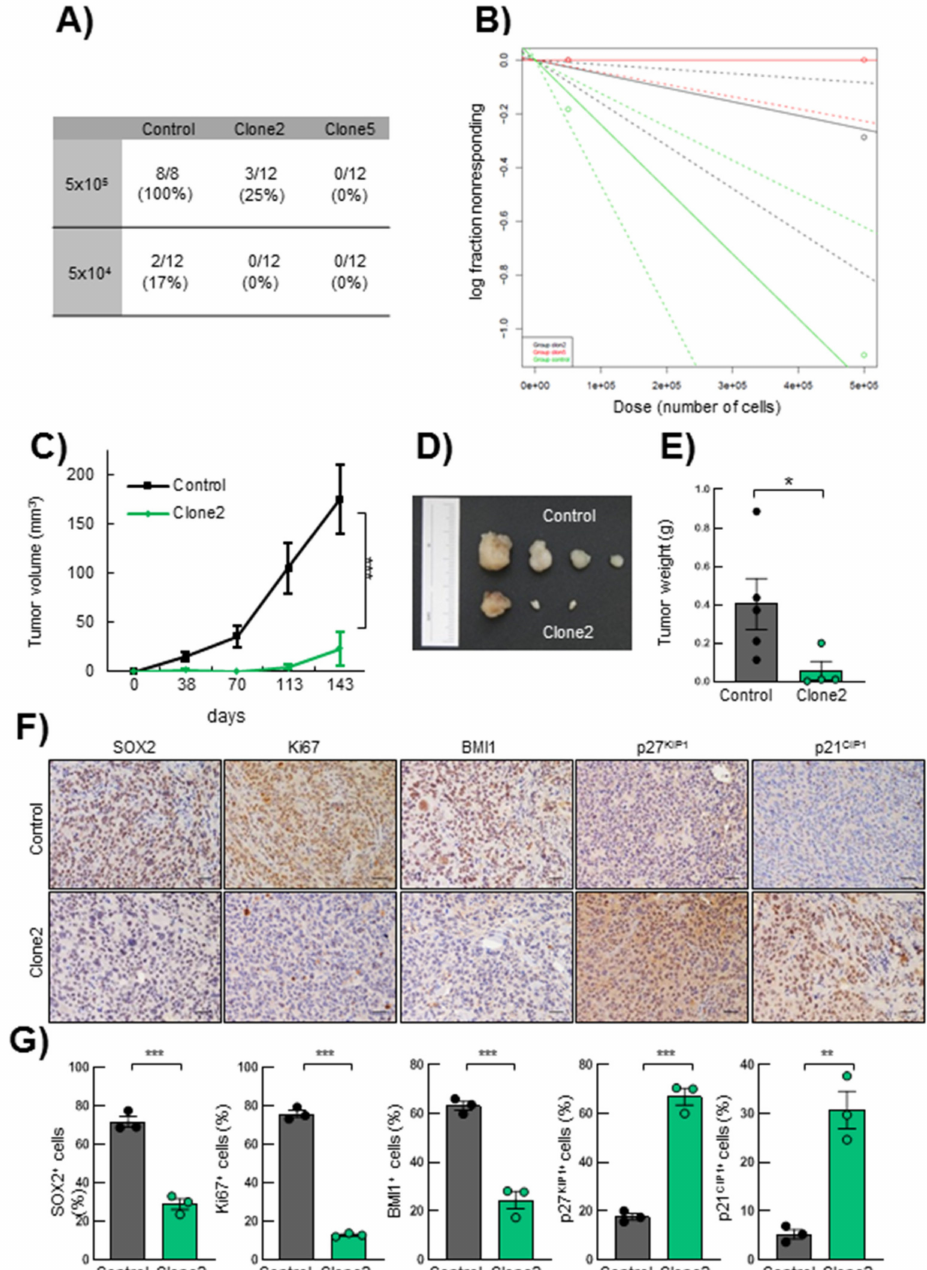
Figure 6. SRR2 deletion affects tumor initiation and progression in vivo. ( A ) Table of incidence of the number of tumors formed by control, clone2 and clone5 cells after subcutaneous injection of 5 × 10 5 and 5 × 10 4 cited cells in 8-week-old immunosuppressed Foxn1 nu /Foxn1 nu nude mice ( n = 12). ( B ) Logarithmic representation of the tumor initiation frequency after subcutaneous injection of different concentrations of control, clone2 and clone5 cells in nude mice. The incidence of tumor initiation was calculated using the ELDA platform and chi-square tests ( χ 2 ) ( p = 5.92 × 10 − 5 ). ( C ) Graph representing tumor volume developed after subcutaneous injection of control, clone2 and clone5 cells in nude mice measured at the indicated time points ( n = 12). ( D ) Representative image of tumors derived from control and clone2 cells. ( E ) Average weight of the tumors generated. ( F – G ) Representative images and quantification of SOX2, Ki67, BMI1, nuclear p27 KIP1 and p21 CIP1 immunohistochemical staining on sections from control and clone2 tumors, scale bar = 100 µ m. The statistical significance was obtained with the Student’s t -test (* p < 0.05, ** p < 0.01 and *** p <